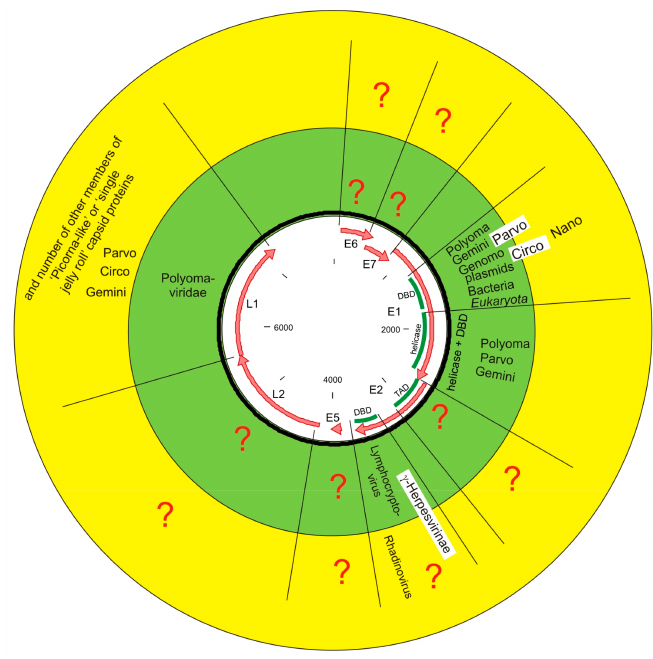
Figure 4. Summary figure of the relationship of PV domains with other parts of the biosphere. Virus family names are abbreviated without “- viridae ” suffix. In the green circle, the relationships according to SCOP and SUPERFAMILY resource are shown. In the yellow circle, the relationships according to extended structural analysis from published articles and structures are shown. Genera Lymphocryptovirus and Rhadinovirus are subfamilies of γ -Herpesvirinae. For E1 helicase domain only evolutionary relationship via domain pair SF_55464:SF_52540 are